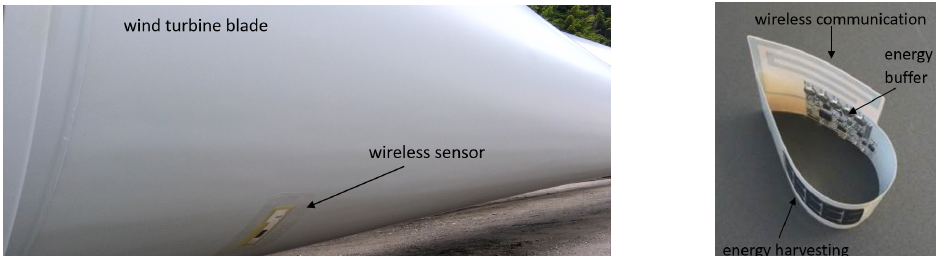
Figure 2. ( Left ) Exemplary sensor mounting on the outside of the blade during construction of a wind turbine. ( Right ) Demonstration of flexible sensor